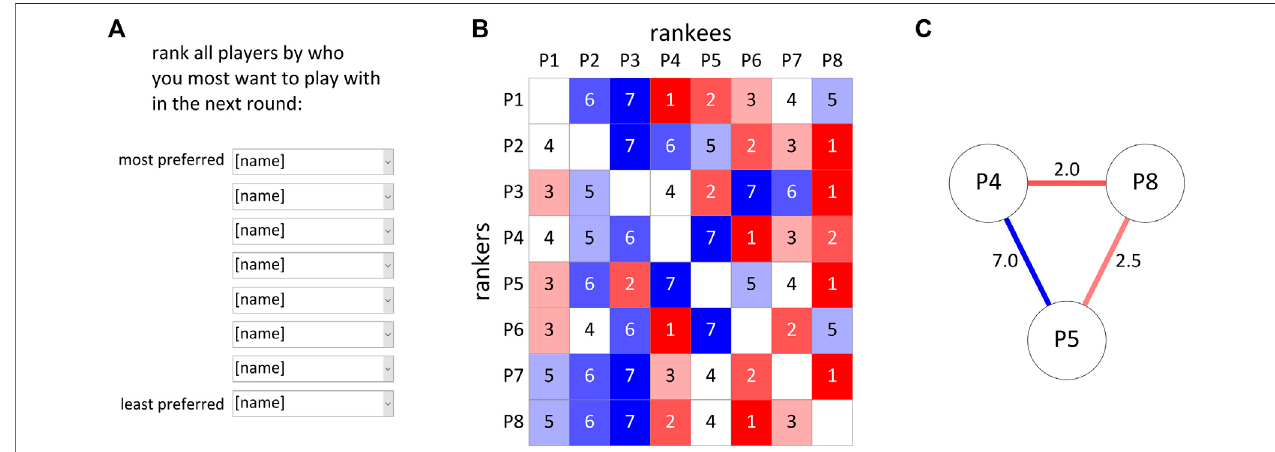
FIGURE 4 | Example of social distance metric obtained from teammate preference rankings. (A) Players used drop-down lists to rank the other players. (B) Asymmetric ranking matrix, values represent teammate preference order. (C) Symmetrized social distances for the subnetwork of P4, P5, and P8, derived by averaging pairwise asymmetric rankings.